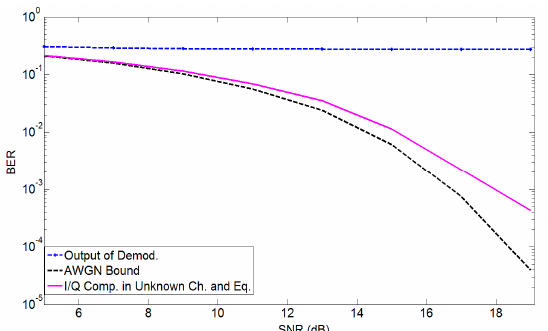
Figure 10. BER vs. SNR for the proposed model for 16 QAM OFDM signal with 1024 subcarriers for g = g ’ = 0.5 dB and θ = θ ’ = − 2 degrees.